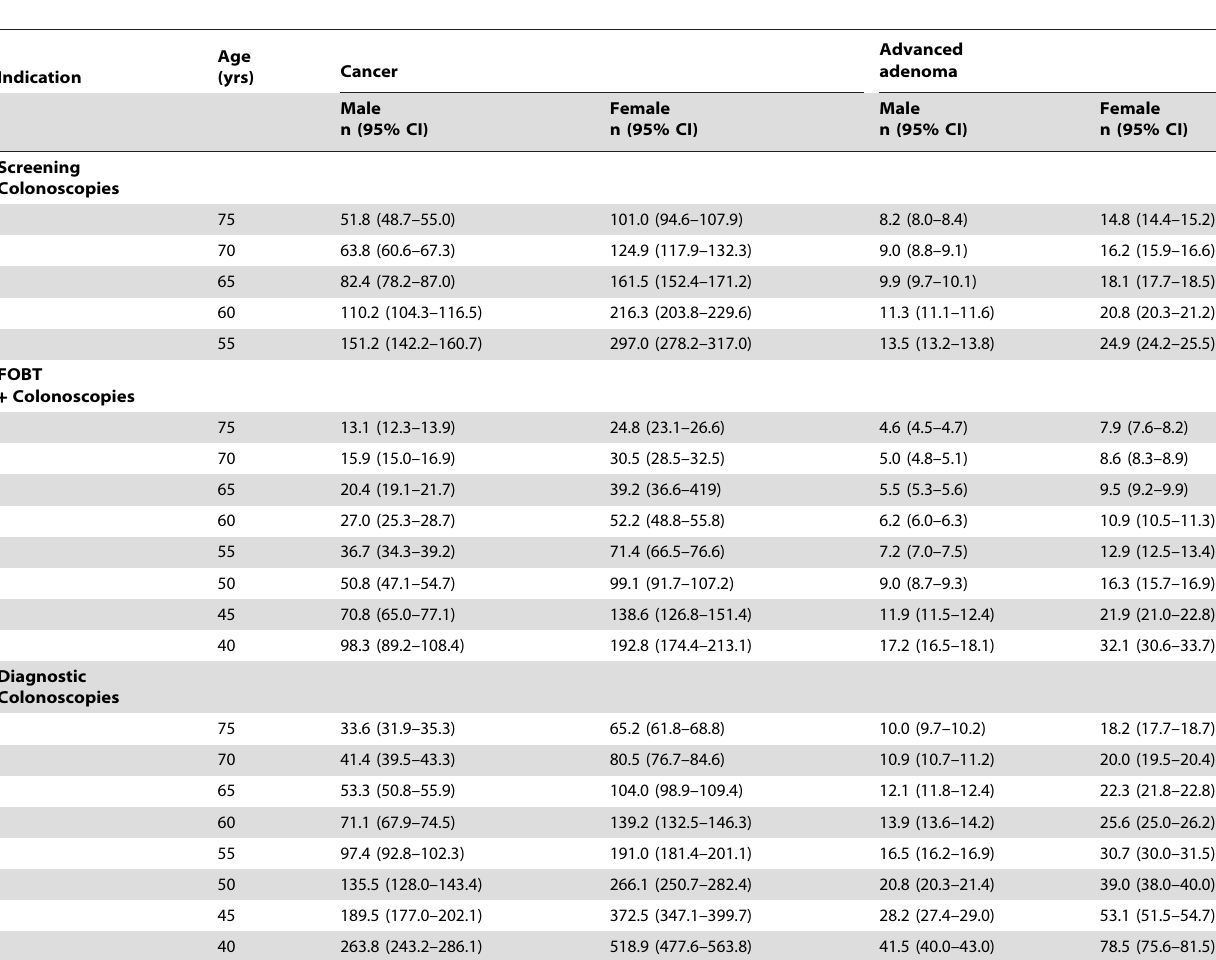
Table 4. Number of colonoscopies needed to identify cancer or advanced adenoma.